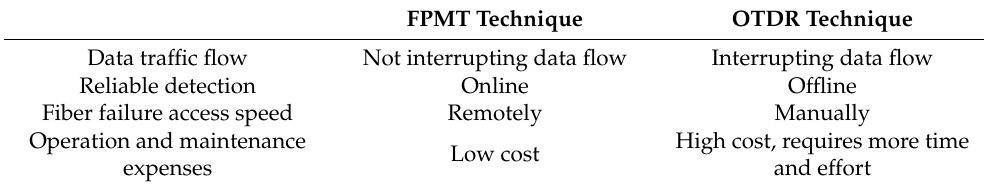
Table 7. Comparison between proposed FPMT technique and traditional OTDR technique.